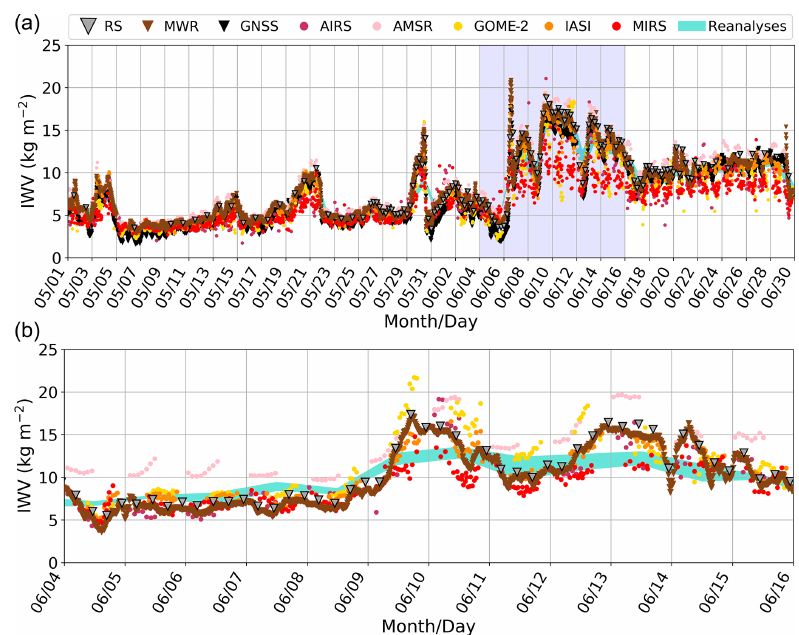
Figure 2. Time series of reference data (GNSS, MWR, radiosonde (RS)), reanalyses and satellites (see legend for explanation of symbols) at the two ACLOUD central sites Ny-Ålesund (a) and the R/V Polarstern ice camp (b) . The time period of the ice camp is indicated in blue in the time series for Ny-Ålesund. Note that GNSS is not available for Polarstern . The cyan shaded area indicates the minimum and maximum values of the reanalyses.